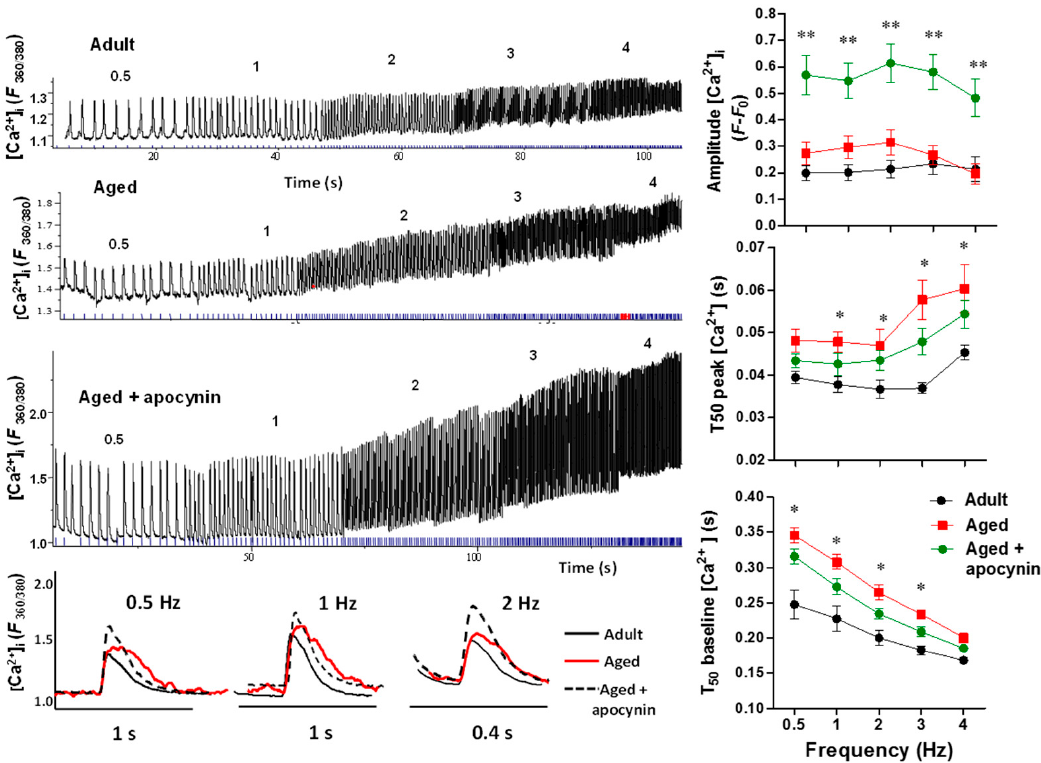
Figure 3. Intracellular Ca 2+ transients. [Ca 2+ ] i transients in response to increase in frequency of stimulation from 0.5 to 4 Hz. Upper left panel, representative traces of intracellular calcium in myocytes from adult ( n = 17), aged ( n = 23), and aged myocytes treated with apocynin 50 µmol/L ( n = 18). The numbers on the traces indicate the frequency of stimulation. The lower panel shows representative traces with more temporal resolution depicting transients evoked at 0.5, 1, and 2 Hz. The graphs depict the amplitude of [Ca 2+ ] i transients, time 50 to reach peak [Ca 2+ ] i (T 50 peak [Ca 2+ ] i , and time 50 to reach relaxation (T 50 baseline [Ca 2+ ] i ). * p < 0.05 vs. adult, ** p < 0.001 vs.